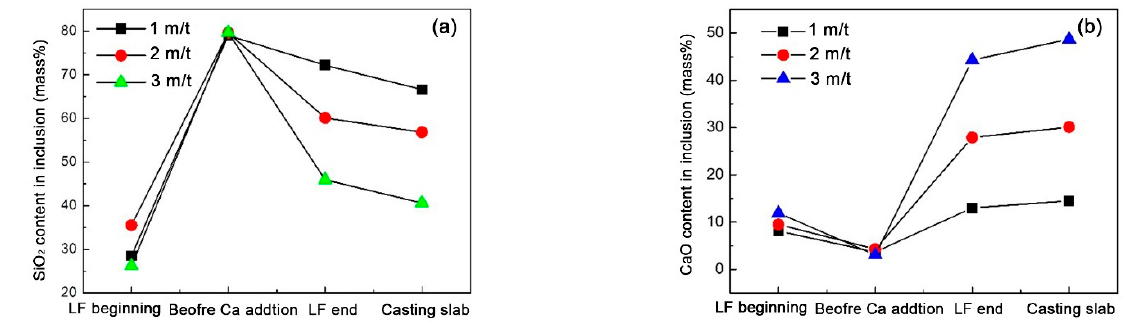
Figure 11. Influence of calcium addition amount on SiO 2 and CaO contents of inclusions at each stage. ( a ) SiO 2 content, ( b ) CaO content.